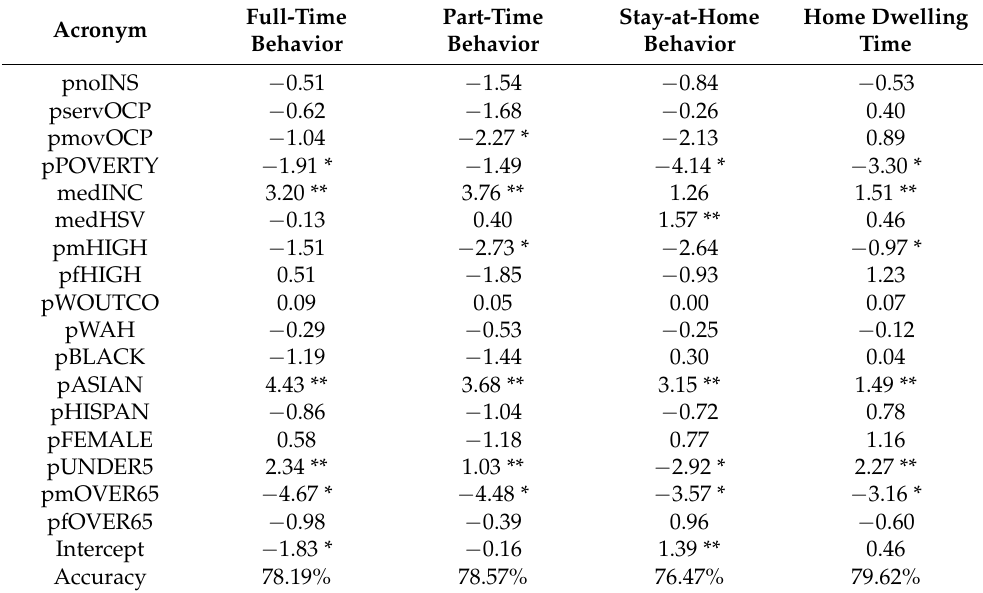
Intercept Accuracy 78.19%